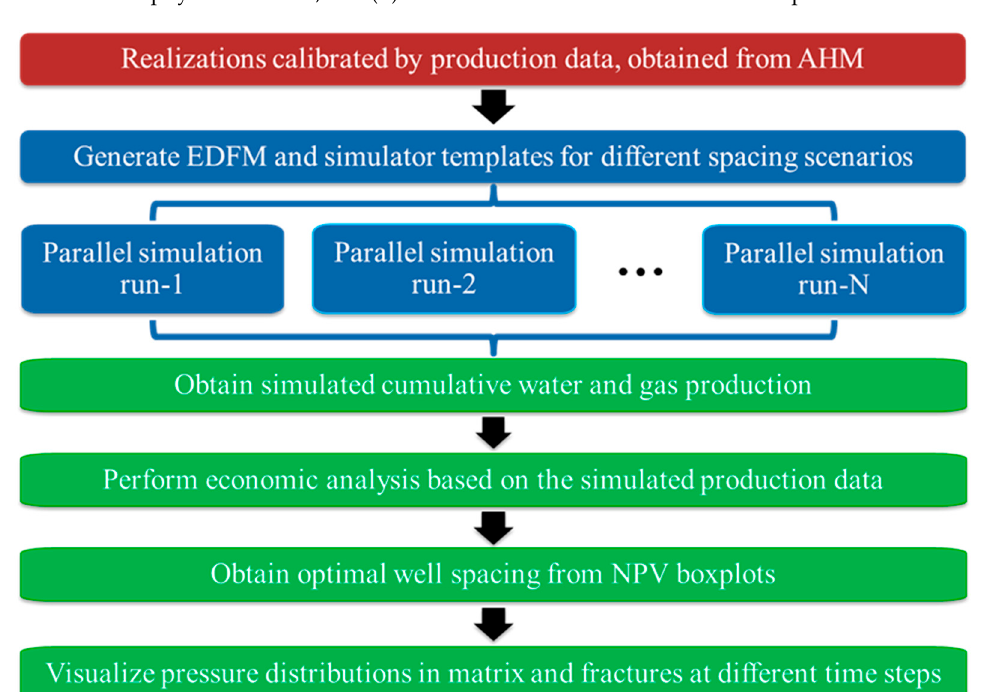
Figure 2. Flowchart of the well spacing optimization workflow in the shale gas reservoirs (AHM represents assisted history matching and NPV represents net present